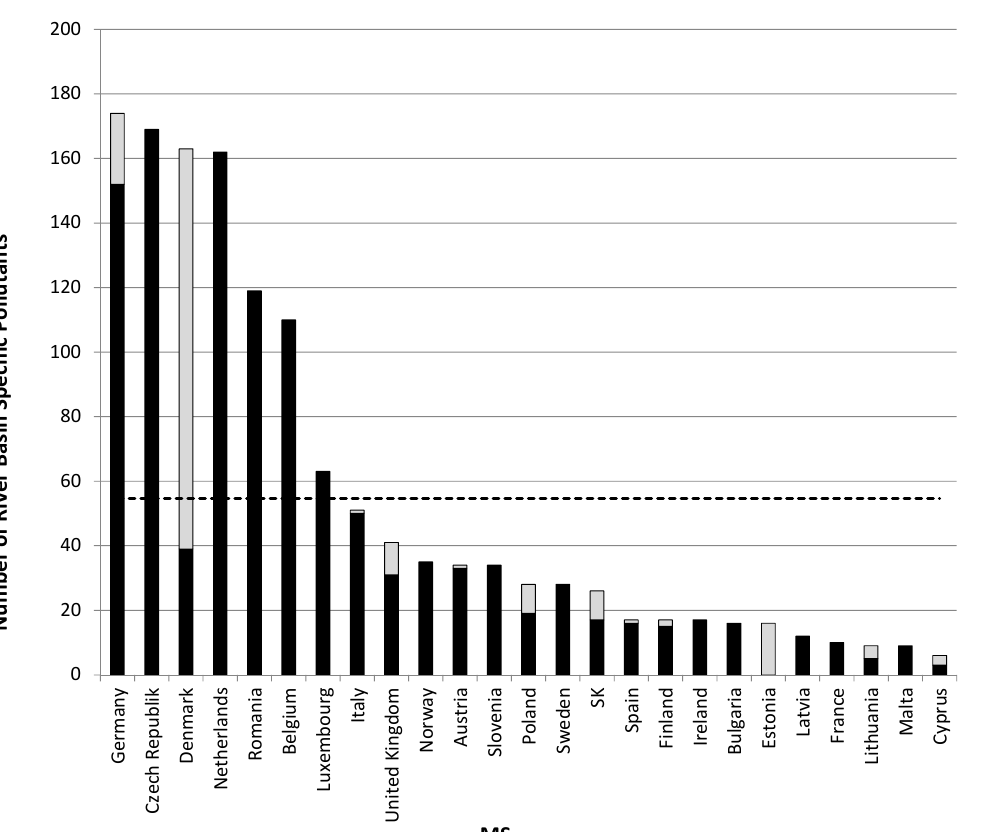
Figure 3. Number of river basin specific pollutants of the Member States as reported to the EU Commission within the first management plan period (black bars after Arle et al. , 2012 [22]) and updated numbers based on MS requests (grey bars after Irmer et al. , 2014 [23]). Dotted line = mean number of substances used by the MS as RBSPs, after Irmer et al. , 2014 [23]. The divergence between highest and lowest EQS for the same substance is exemplary for some substances visualized in Figure 4. All MS in question indicated identical EQSs for 40 substances (about 15%). Minimum and maximum EQS values for one third of the listed substances differ up to tenfold from each other. The values of a little more than half (53%) of all substances differ from more than tenfold to 10 5 -fold from each other. Most of the differences observed seemed to not be caused by differences in the safety factors used by the MS. Rather the differences are indicative of differing approaches used by the MS to derive the EQSs. Under the WFD, EQSs for RBSPs are derived according to rules set out in Annex V, 1.2.6 which should eliminate flexibility of standard values in future. In many cases, the results for other water categories (lakes, transitional waters and coastal waters) also showed similar discrepancies between the highest and lowest EQSs for the same substance. The number of RBSPs regulated by the MS in lakes, transitional waters and coastal waters was considerably lower than those regulated in rivers. Comparisons of the MS EQSs for different pollutants with PNEC freshwater —values available at the official webpage of the European Chemicals Agency (ECHA) (cf. [24]) and the National Recommended Water Quality Criteria—Aquatic Life Criteria Table of the United States Environmental Protection Agency (cf. [25]) indicate a generally high international variability in the threshold levels for different pollutants that are assumed to be protective of aquatic life. To ensure that the assessments of the ecological status in the EU may be comparable and that programs of measures aiming at reducing pollutant inputs into surface waters may coherently be initiated under the WFD, harmonization, at the European level, of EQSs for RBSPs is needed.